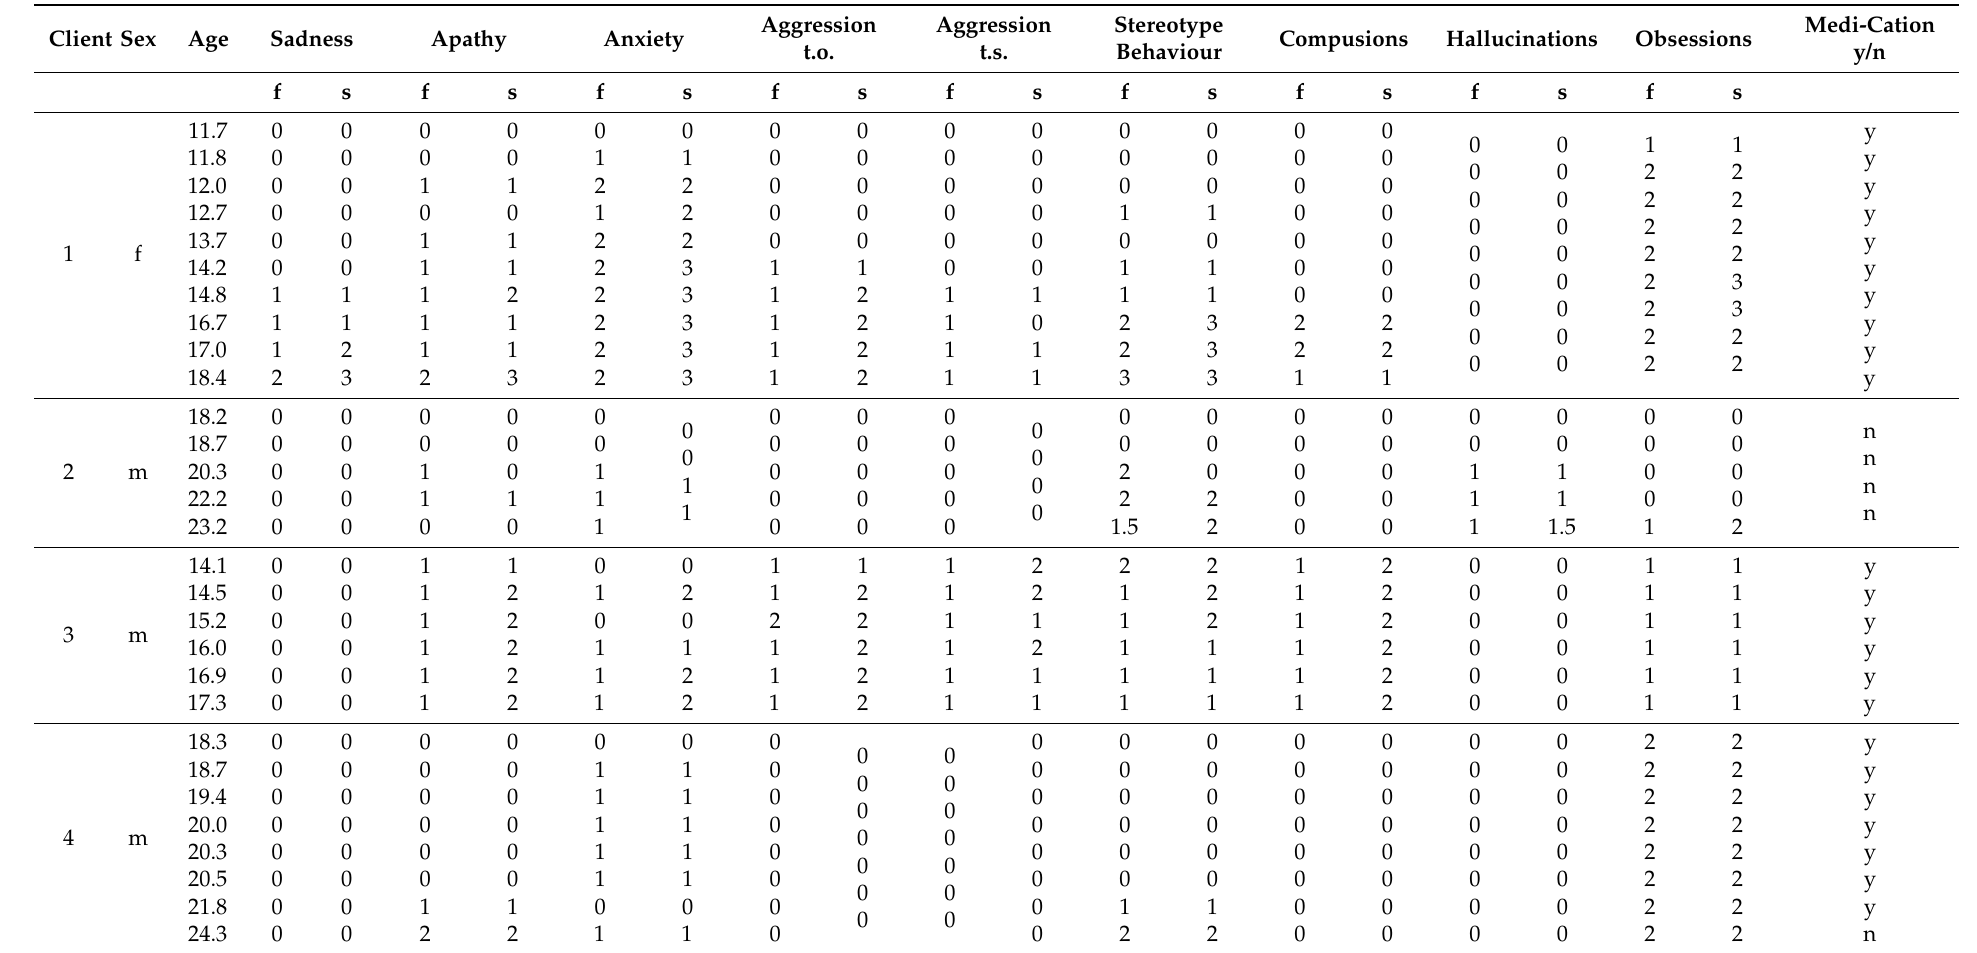
Table A2. The UBDRS-data for the (seven) clients from Table